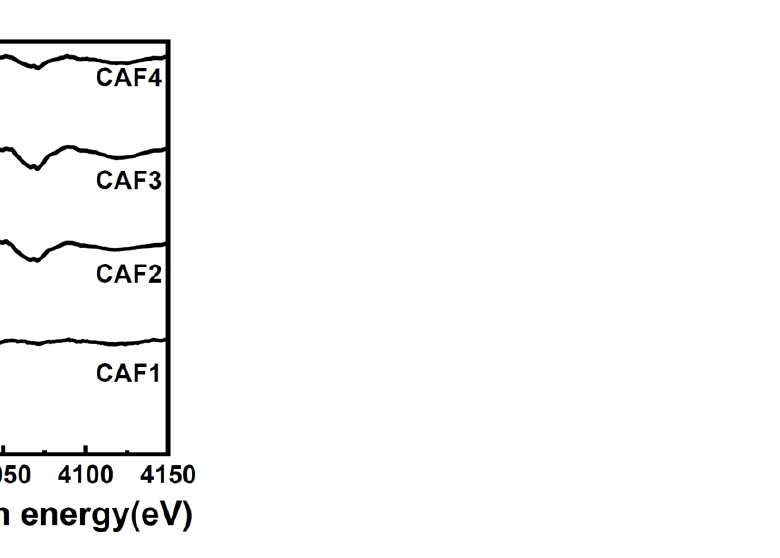
Figure 4. Ca K-edge XANES spectra for Ca – Al – Fe LDHs with various Ca/Al/Fe